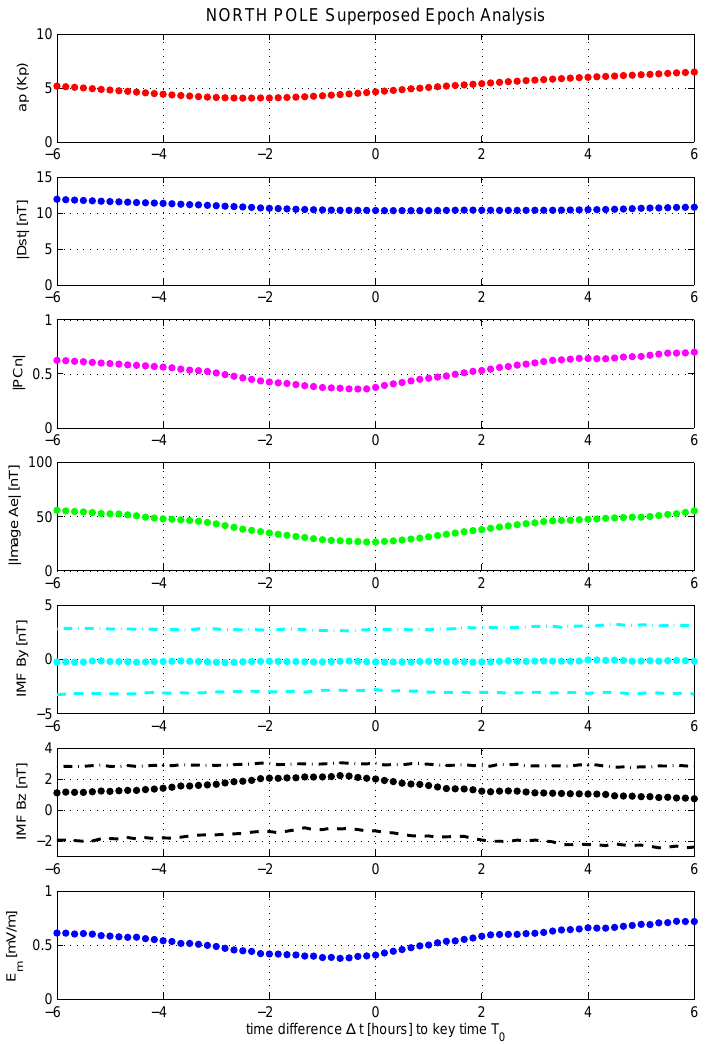
Fig. 8. The Superposed Epoch Analysis reflects the average development of activity indices relative to the time of detection of a quiet polar ionosphere. The parameters ( a p , D st , PC n , IMAGE- AE , IMF B y , IMF B z and merging electric field E m ) are centered at the key time T 0 , which is the closest approach of the spacecraft to the geomagnetic pole. The dashed lines in the B z and B y diagrams mark the respective negative and positive mean